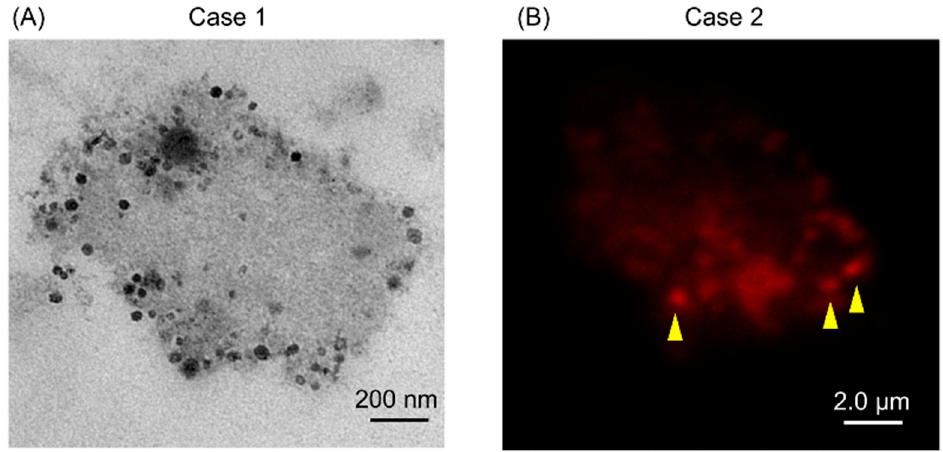
Figure 1. ( A ) Transmission electron microscopy (TEM) showed that extracellular vesicles (EVs) in gastric juice (GJ) of gastric cancer (GC) patient were covered with mucus. Two cases of GJ were examined; ( B ) CD63 was partially positive (yellow arrowhead) in GJ of GC. One case of GJ was examined.